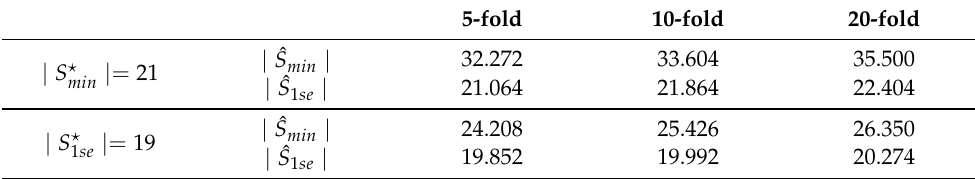
Table 6. Mean of selected model size | ˆ S | :